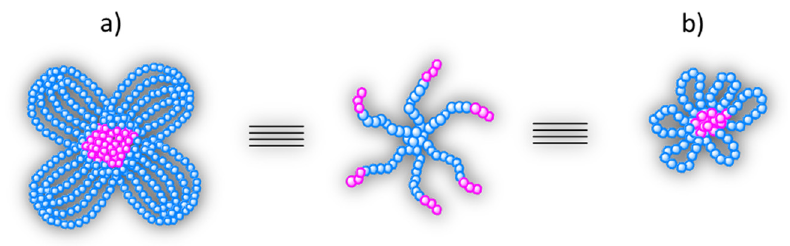
Figure 7. Self-assembly in aqueous solution of star (PNVCL- b -PVAc) 6 block copolymers: ( a ) multiple star micelles; and ( b ) single flower-like micelle.